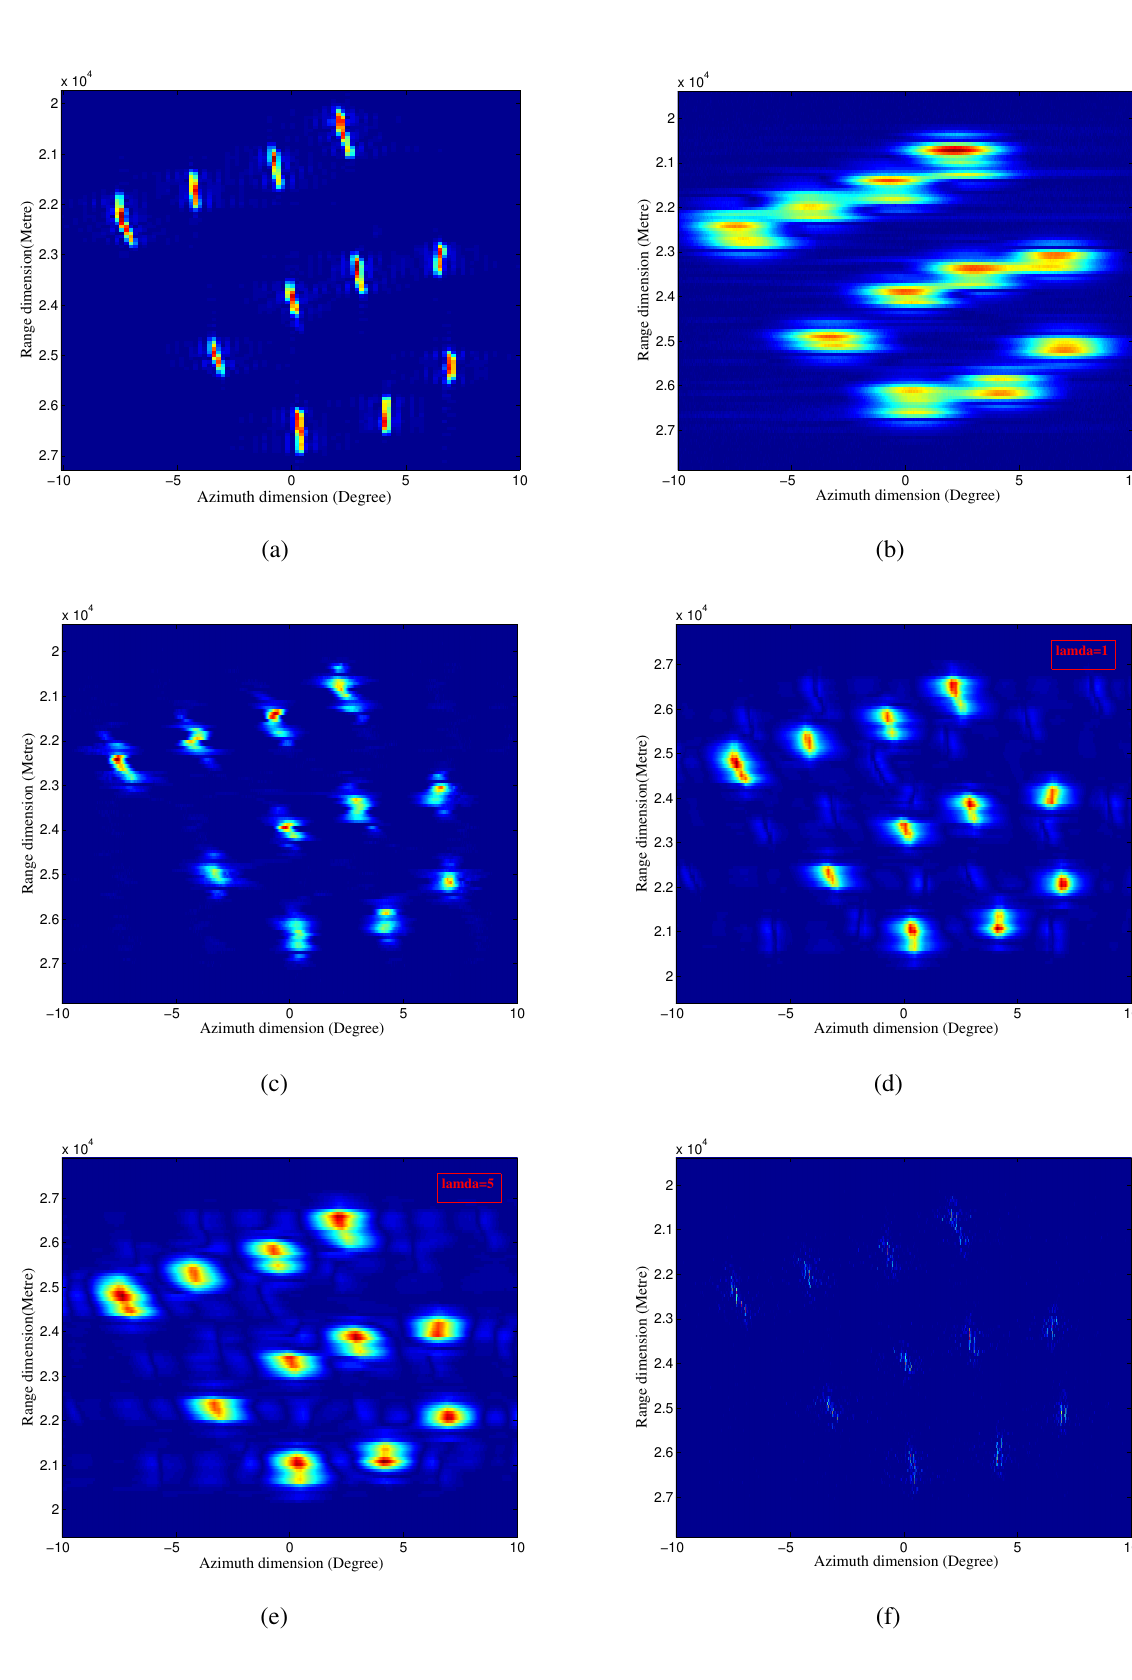
Figure 5. Simulation results of the scene when the imaging region is from − 10 ◦ to 10 ◦ . ( a ) Original scene. ( b ) Real aperture image. ( c ) RL algorithm. ( d ) Tikhonov regularization when λ = 1 . ( e ) Tikhonov regularization when λ = 5 . ( f ) Proposed MAP algorithm when q = 0 . 95